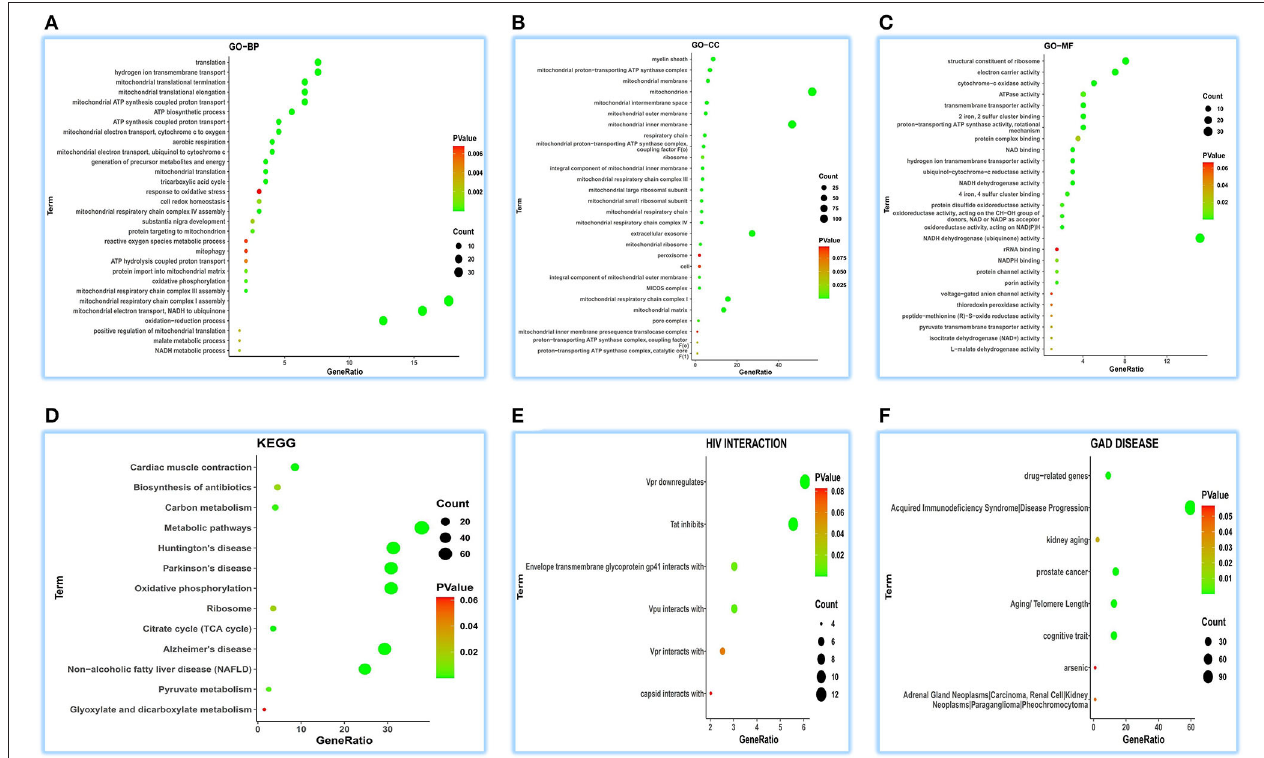
FIGURE 2 | Functional annotations of ATP5MG in the human heart by coRNA analysis. The analysis of GO, KEGG, HIV interaction and GAD DISEASE based on two hundreds of coexpression genes of ATP5MG was conducted using DAVID. ATP5MG may present various functions, obviously focused on mitochondrial energy metabolism and related to infection, inflammation, or immune-related function in the heart. (A) Functional annotations by GO-BP analysis. (B) Functional annotations by GO-CC analysis. (C) Functional annotations by GO-MF analysis. (D) Functional annotations using KEGG analysis. (E) Functional annotations by HIV interaction analysis. (F) Functional annotations by GAD DISEASE analysis. GO, Gene Ontology; BP, biological process; CC, cellular component; MF, molecular function. KEGG, Kyoto Encyclopedia of Genes and